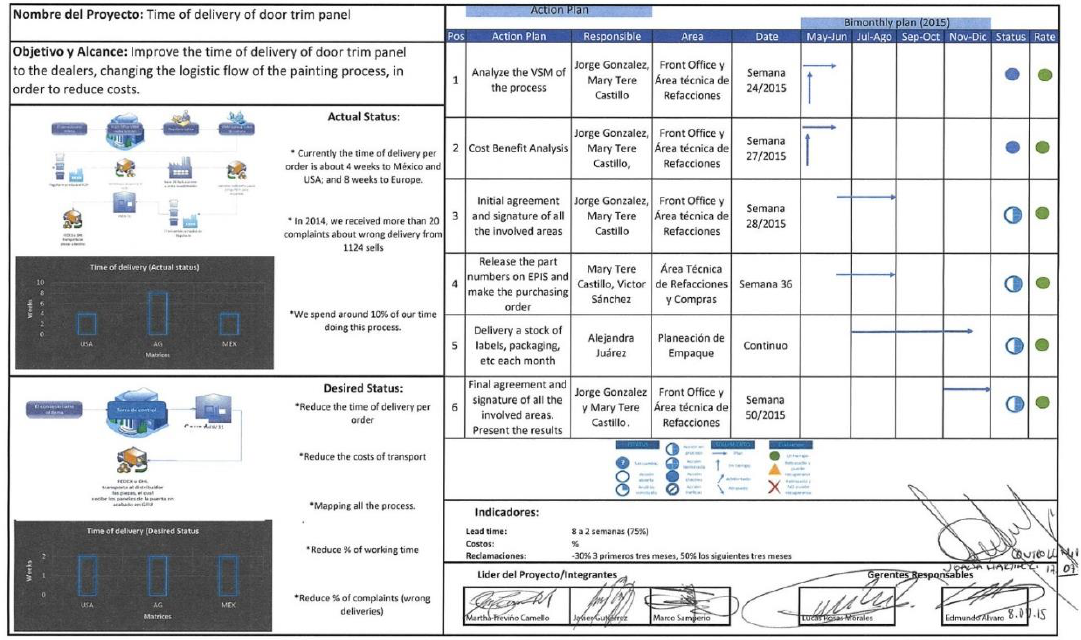
Figure 22. The fourth part of four of the future state map is displayed.